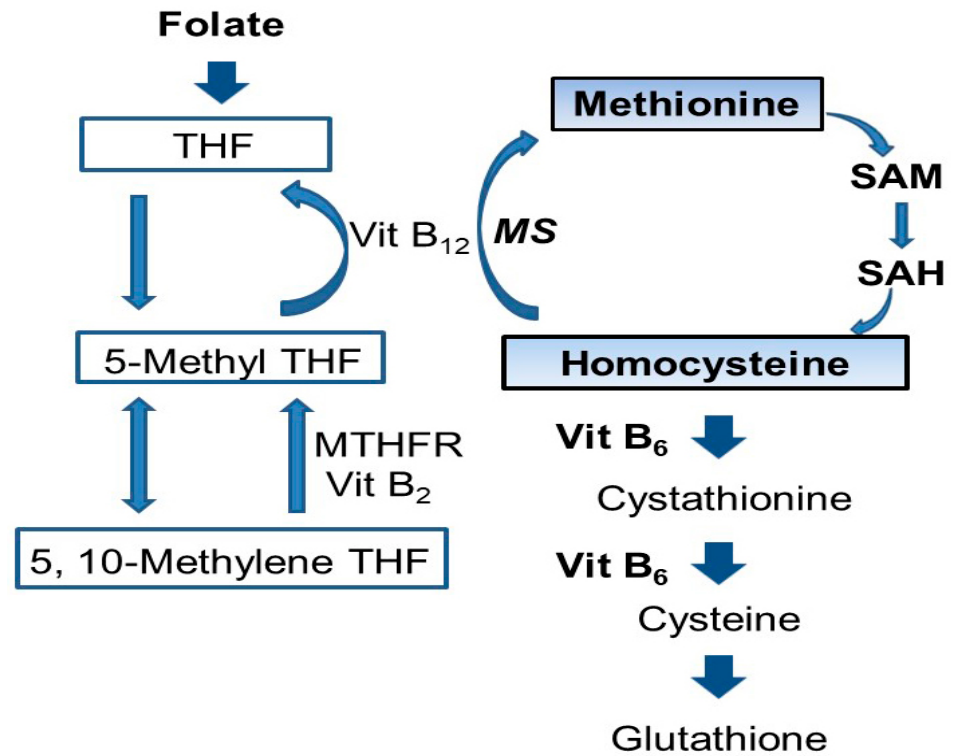
Figure 1. Homocysteine (Hcy) metabolic pathway. Folate and vitamin B 12 are cofactors in one carbone metabolism, during which they promote the remethylation of homocysteine. Vitamin B 12 and folate deficiency inhibits metabolism from Hcy to methionine and causes hyperhomocysteinemia (HHCy). Vitamin B 6 deficiency also inhibits the conversion of Hcy to cystathionine and causes hyperhomocysteinemia. SAM: S-adenosylmethionine; SAH: S-adenosylhomocysteine; Hcy: homocysteine; Vit B 6 : vitamin B 6 , Vit B 12 : vitamin B 12 ; MTHFR: 5, 10-methylenetetrahydrofolate reductase; MS: methionine synthase; THF: tetrahydrofolate.